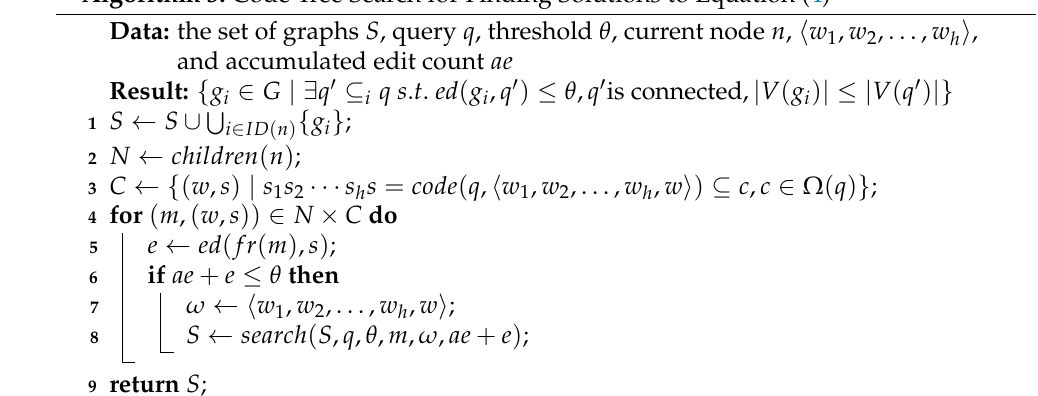
Algorithm 3: Code Tree Search for Finding Solutions to Equation